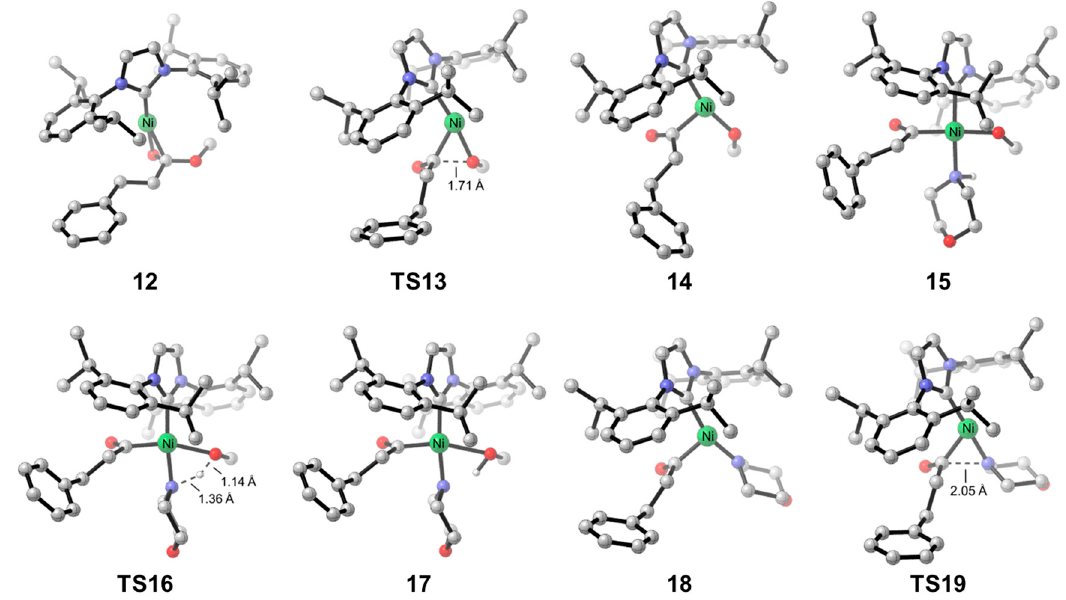
Figure 4. Optimized structures of selected intermediates and transition states in the catalytic cycle of Ni/IPr-catalyzed amidation of ester.